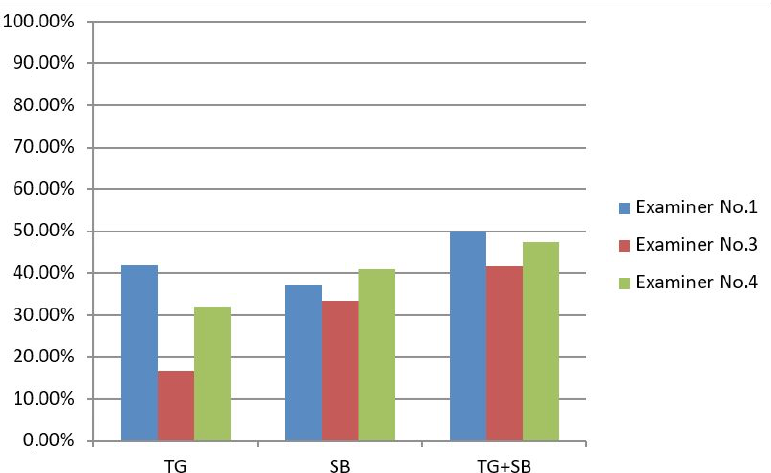
Fig. 3. Inter-individual variability of detection rates in the repeated biopsy group. Systematic biopsy (SB), targeted biopsy